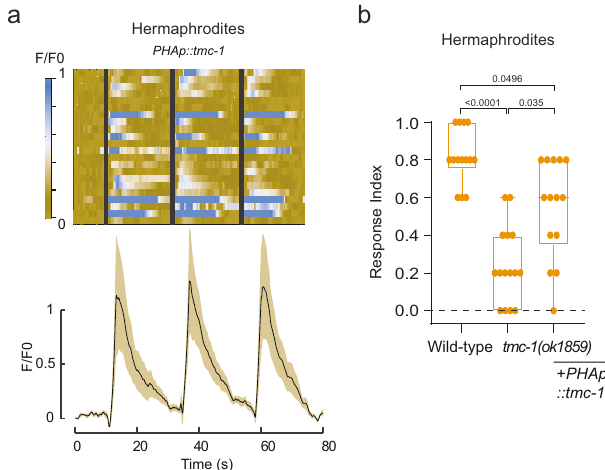
Fig. 6| Over-expressionofTMC-1inPHA canelicit amechanosensory response in hermaphrodites. a AVG GCaMP6s calcium responses of hermaphrodites with PHAp::tmc-1 to three consecutive tail mechanical stimulations. Stacked kymo- graphs represent the GCaMP intensity vs. time of individual recordings. Graphs represent average and SD traces of AVG calcium responses. Black vertical lines representthe timewhenastimuluswas applied. n =23recordingsfrom15animals. FullstatisticalanalysiscanbefoundinSupplementaryFig.9. b Tail-touchresponses of wild-type ( n =14), tmc-1(ok1859) ( n =15) and tmc-1(ok1859) ; PHAp::tmc-1 ( n = 14) hermaphrodites. We performed a Kruskal-Wallis test followed by a Dunn ’ s multiple comparison test. Bar graph is a box-and-whiskers type of graph, min to max showing all points. The vertical bars represent the median.